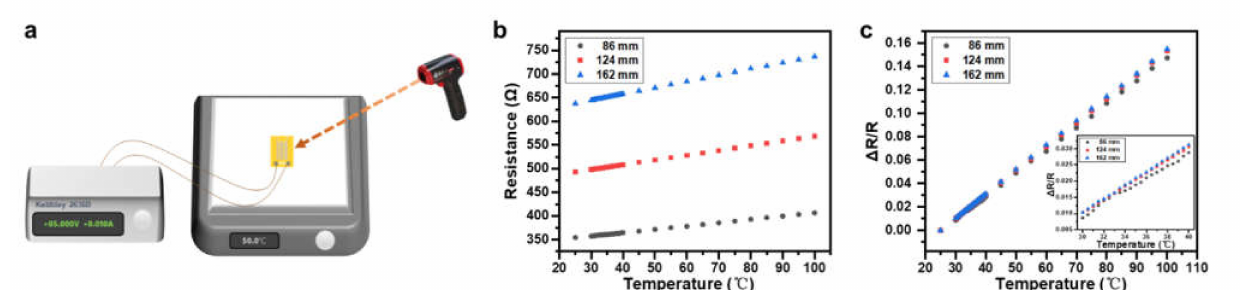
Figure 4. ( a ) Schematic diagram of the experiment setup for the temperature-sensing characterization of the device. ( b ) Resistance change in response to temperature of three temperature sensors with different lengths of wires. ( c ) Relative resistance change as a function of the temperature of these three sensors. Inset: relative resistance changes as a function of temperature in the temperature range from 30 to 40 ◦